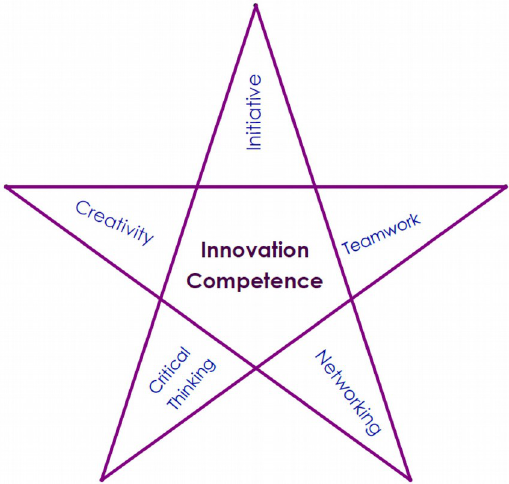
Figure 2. Proposed Model of Innovation